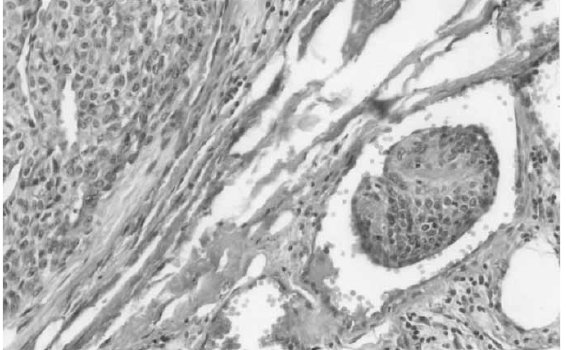
Fig. 1. Neoplastic cells show round to oval nuclei with very distinct cell borders. Note the small but evident nucleoli and the mitotic figure (H&E, (cid:1) 20).